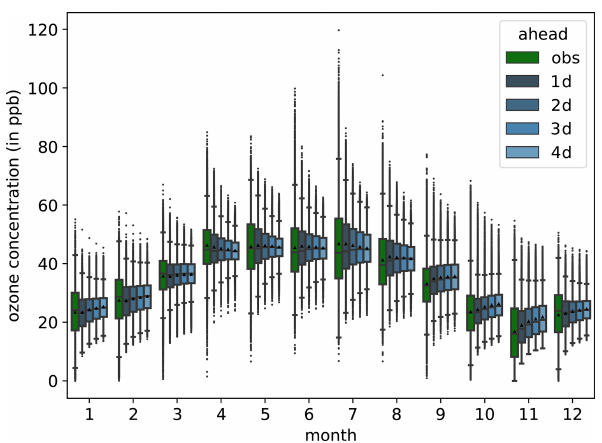
Figure 3. Monthly dma8eu ozone concentrations for all test stations as boxplots. Measurements are denoted by “obs” (green), while the forecasts are denoted by “1d” (dark blue) to “4d” (light blue). Whiskers have a maximal length of one interquartile range. The black triangles denote the arithmetic means.